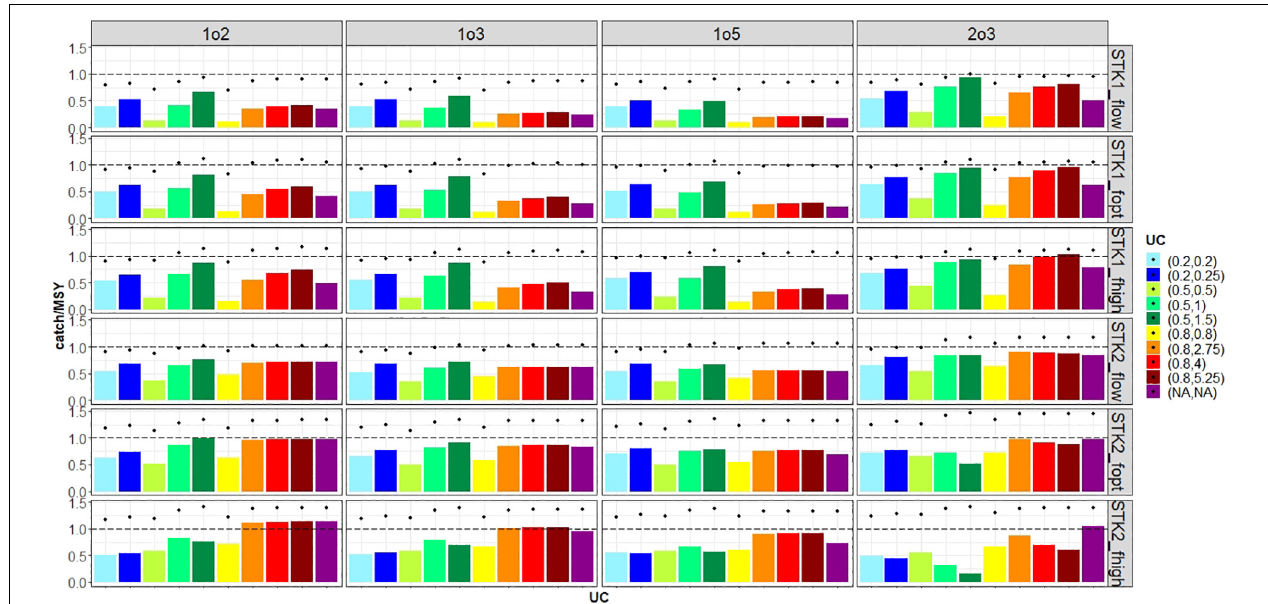
FIGURE 7 | Relative yields (catches/MSY) for the different configurations of the rule in an in-year advice. The rows correspond to the operating models (combination of stock type and the historical exploitation level) and the columns to the harvest control rule type. The uncertainty cap lower and upper limits combinations are represented on the x-axis for alternative timeframes: black dots represent the relative yields in the short-term (first 5 projection years) and the colour bars represent the relative yields in the long-term (last 10 projection years). The horizontal dashed line corresponds to catches at MSY. See Table 1 for definitions of abbreviations. Interactive version of the figure is available online at https://aztigps.shinyapps.io/Sanchezetal2021_FMS/.